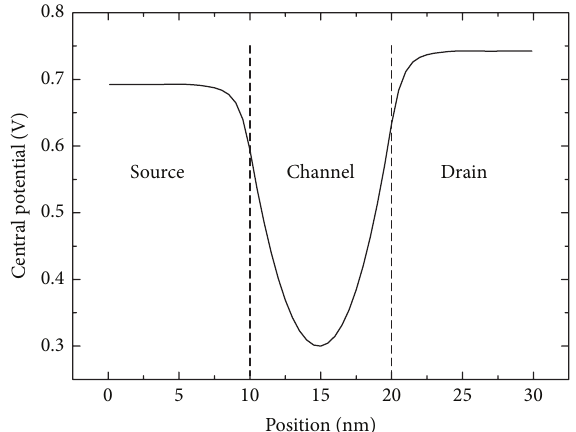
Figure 3: Central electric potential at different positions along the channel obtained from TCAD simulation for 𝑅 = 4 nm and 𝐿 = 10 nm; source and drain length are both 10 nm; 𝑉 𝑉 DS = 0.05 V. The horizontal axis is distance from source electrode. Interfaces between channel and source and channel and drain are depicted by dashed